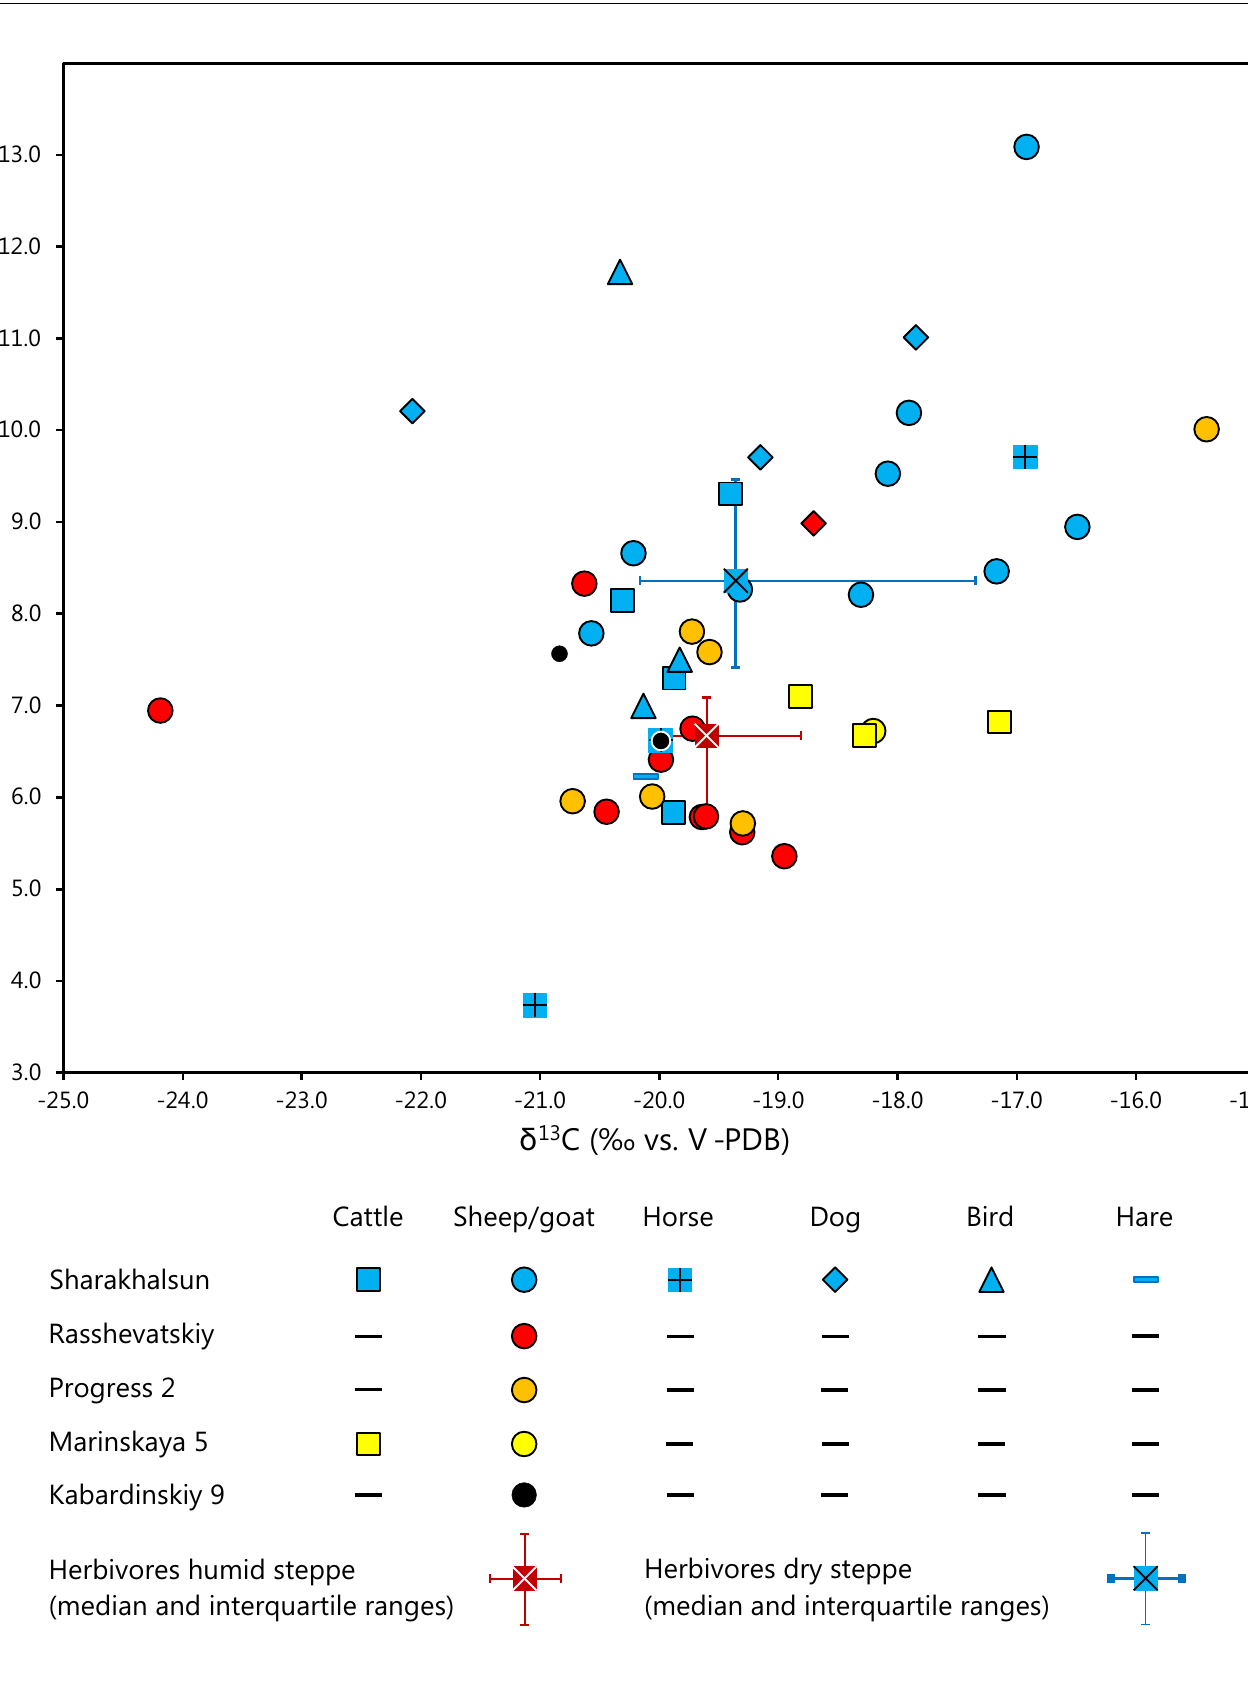
Sheep/goat Horse Dog Bird